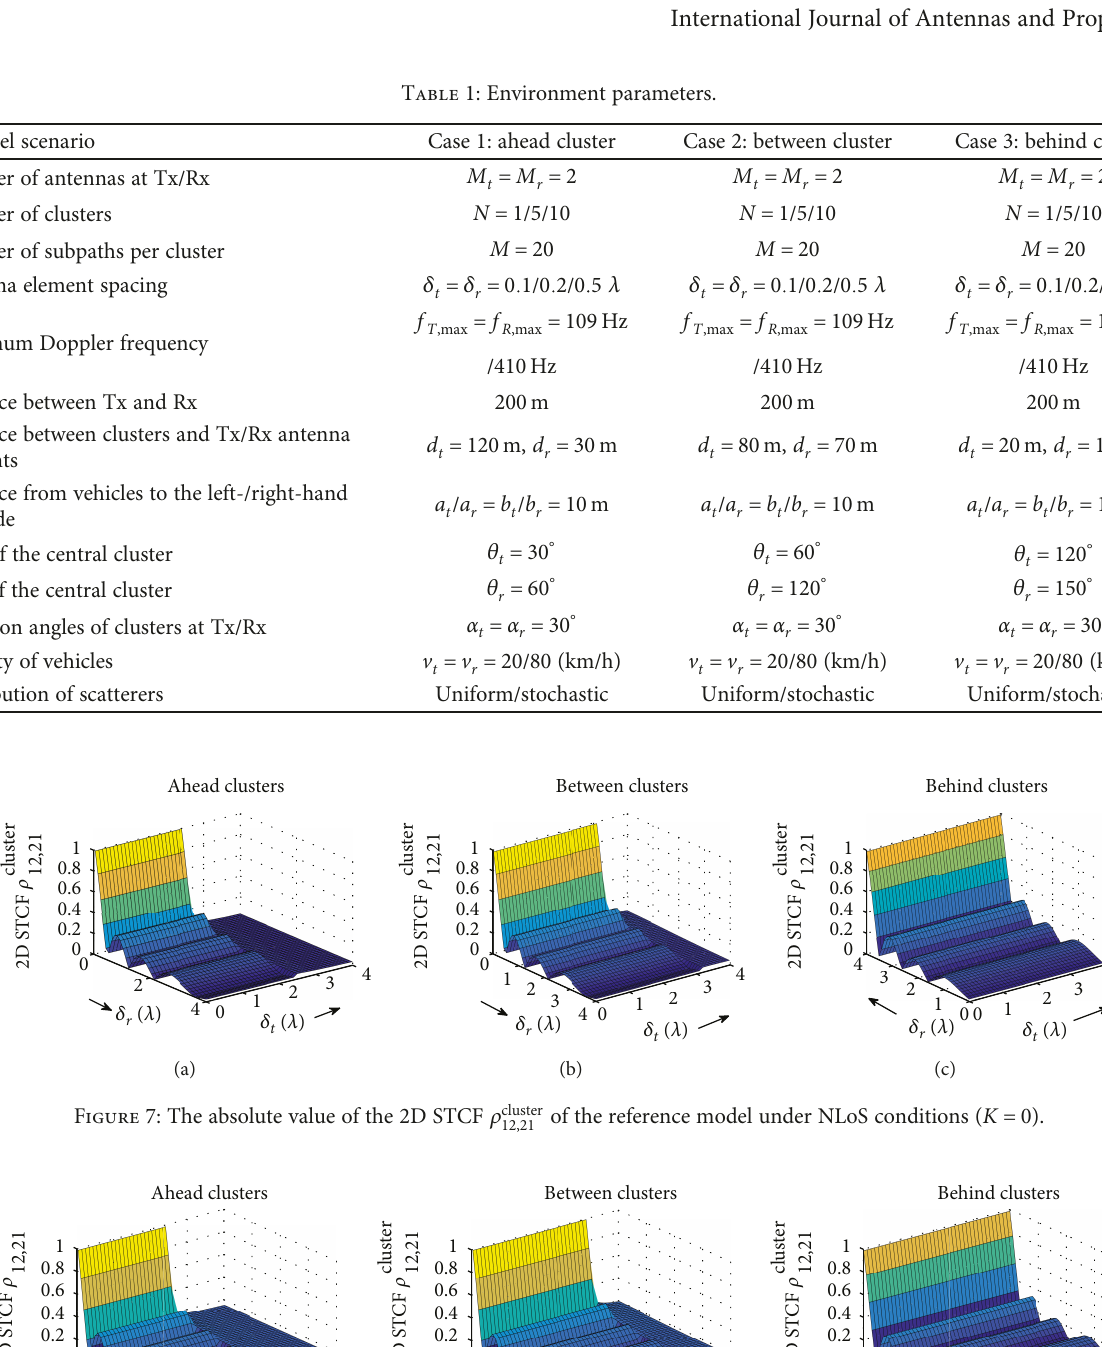
12,21 of the reference model under LoS conditions ( K